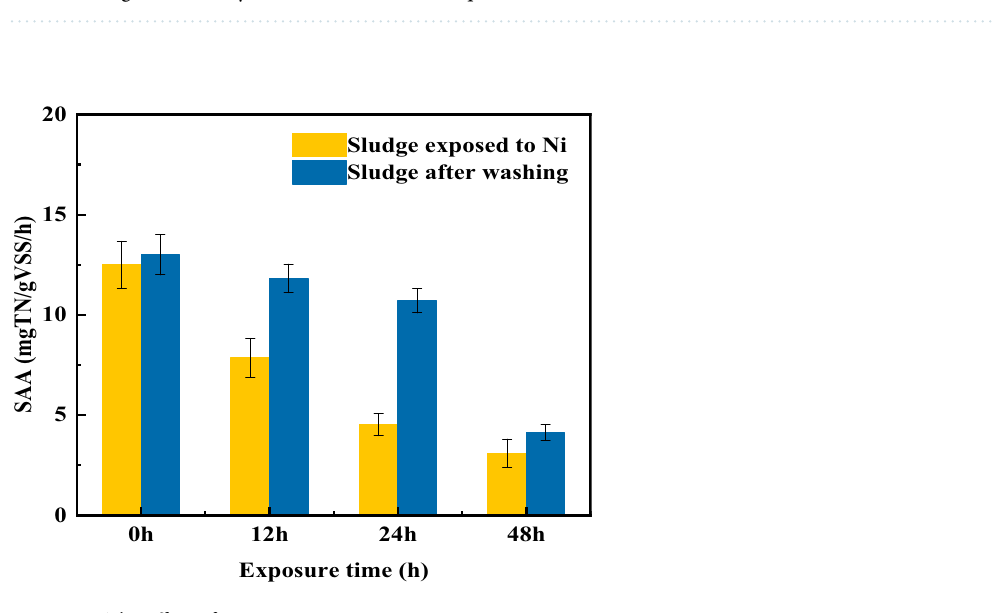
Figure 4. The effect of exposure time on